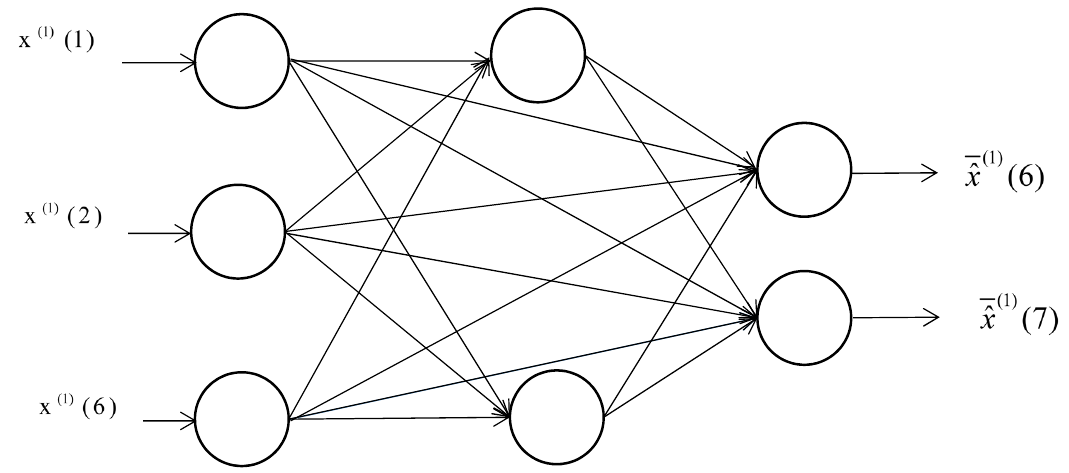
Figure 4. Improved grey RBF neural network structure diagram.